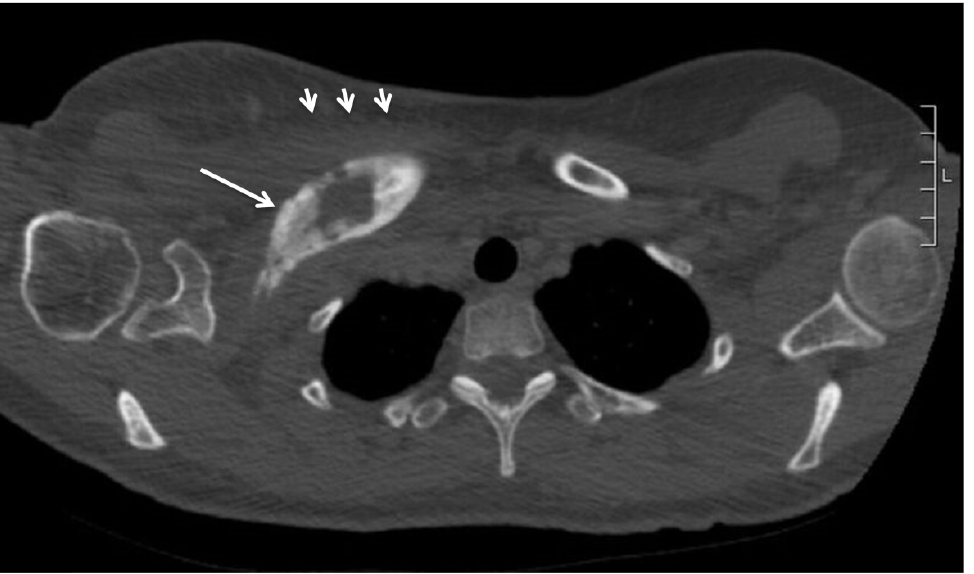
Figure 5. Axial CT image confirms clavicular expansion and reactive bone (long arrow) with surrounding soft tissue infiltration (short arrows), consistent with persistent